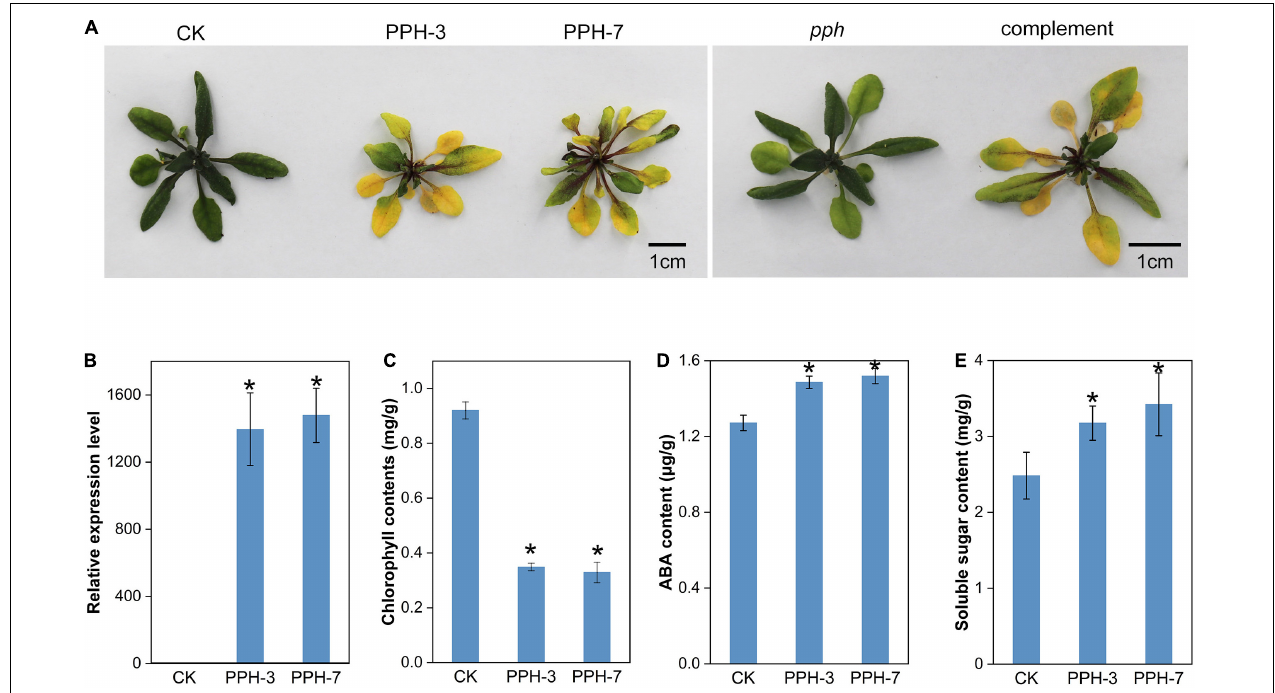
FIGURE 5 | Phenotype observation and physiological determination of ZjPPH -overexpressing lines. (A) Picture of ZjPPH -overexpressing lines and complementary line. (B) Expression-level assessment of ZjPPH in transgenic lines. (C) Chlorophyll contents determination. (D) ABA content. (E) Soluble sugar content. Data were expressed as mean ± SD ( n = 4). *Indicate significant differences at p ≤ 0.05 based on Student’s t